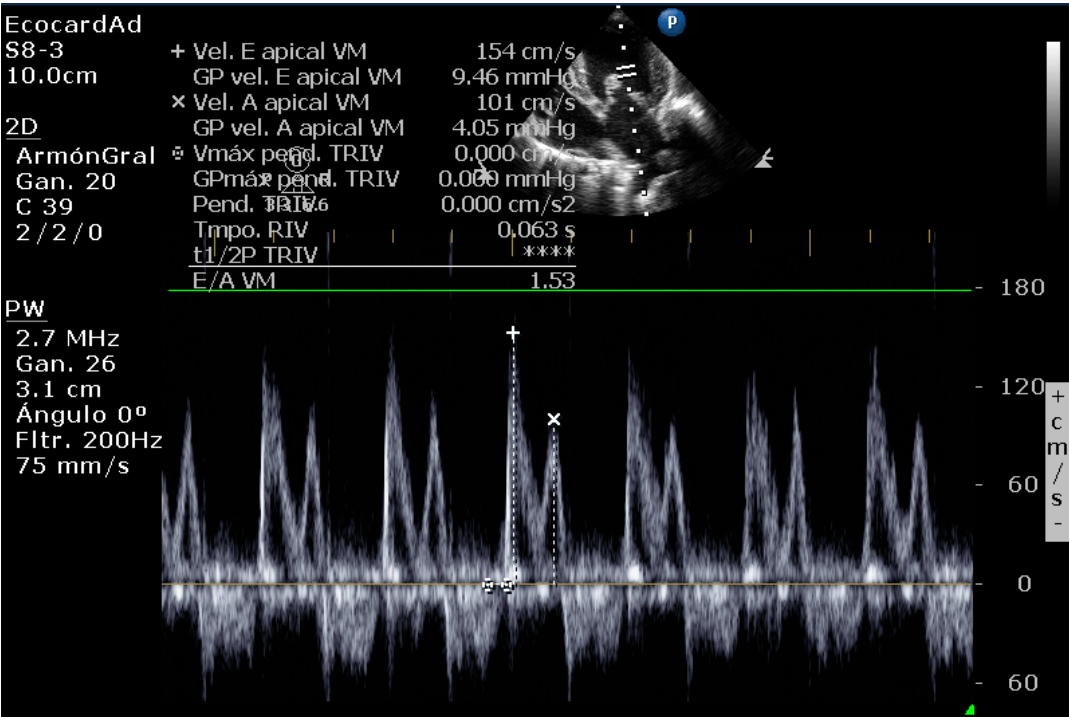
Figure 10. Transmitral Doppler shows increased E-wave velocity in a dog.